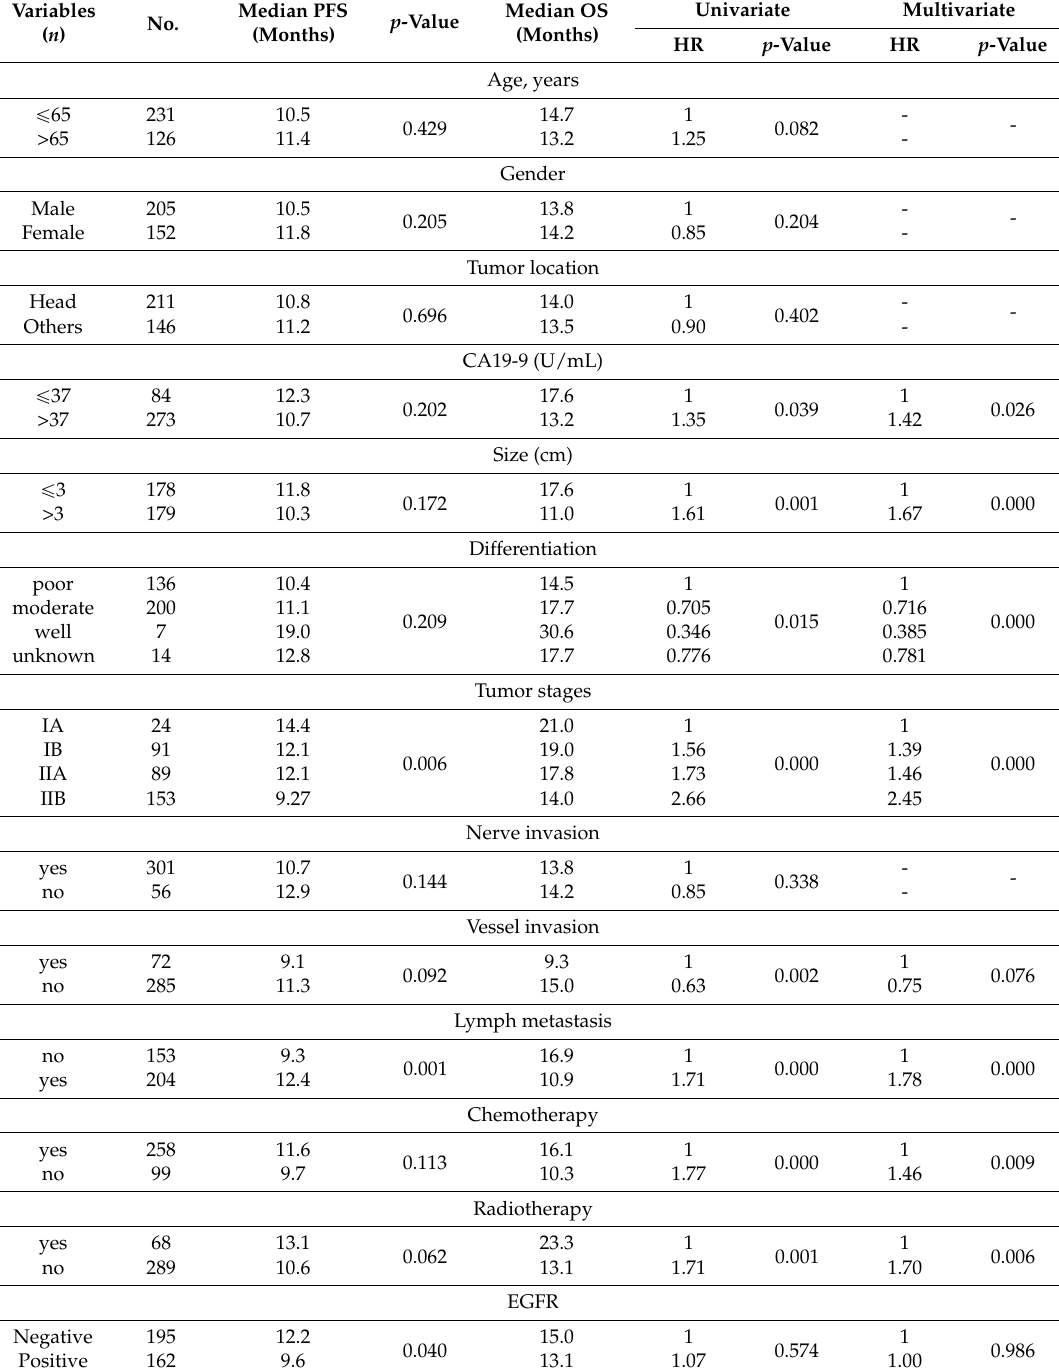
Table 2. Hazard ratios (HR) and p -value for overall survival (OS) and progression free survival (PFS) associated with conventional prognostic factors and EGFR